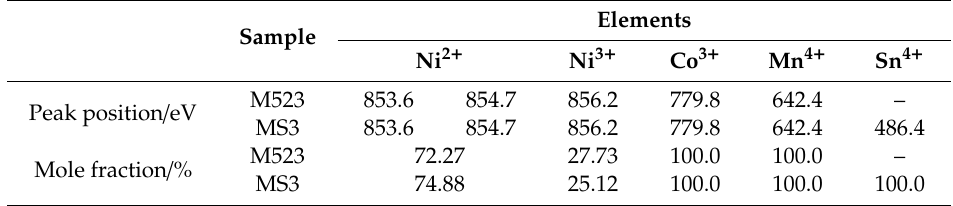
Figure 4. XPS spectra of the synthesized materials: Ni 2p 3 / 2 ( a ) spectra of M523, Ni 2p 3 / 2 ( b ), Sn3d ( c ) spectra of MS3, O1s ( d ) spectra of M523 and MS3. Table 2. Peak positions and mole fractions of the metal elements for M523 and MS3 samples obtained from XPS fittings.